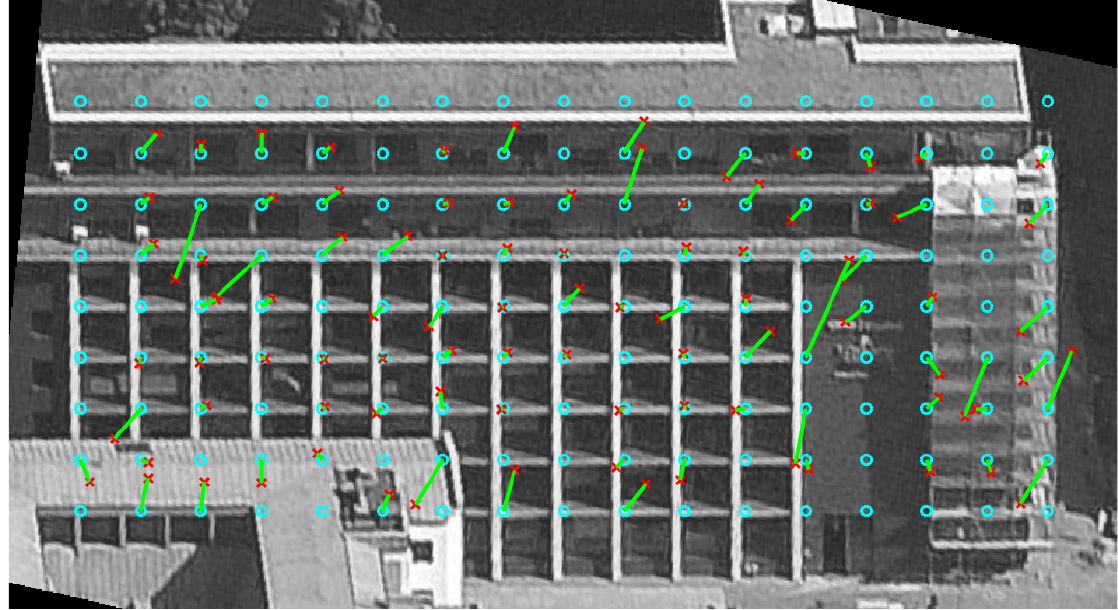
Figure 10: Matching result for case study ’Charlottenstrasse’ with α = 0 . 5 . Original PS positions are marked as red crosses. Lattice nodes are drawn as cyan circles. The matching is indicated by green